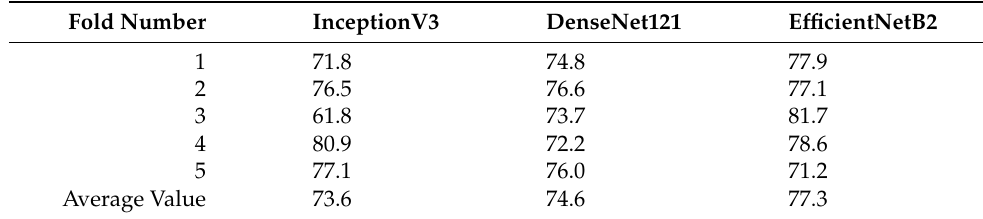
Table 12. Validation accuracy of single Chinese character multi-category classification of FCDP class.